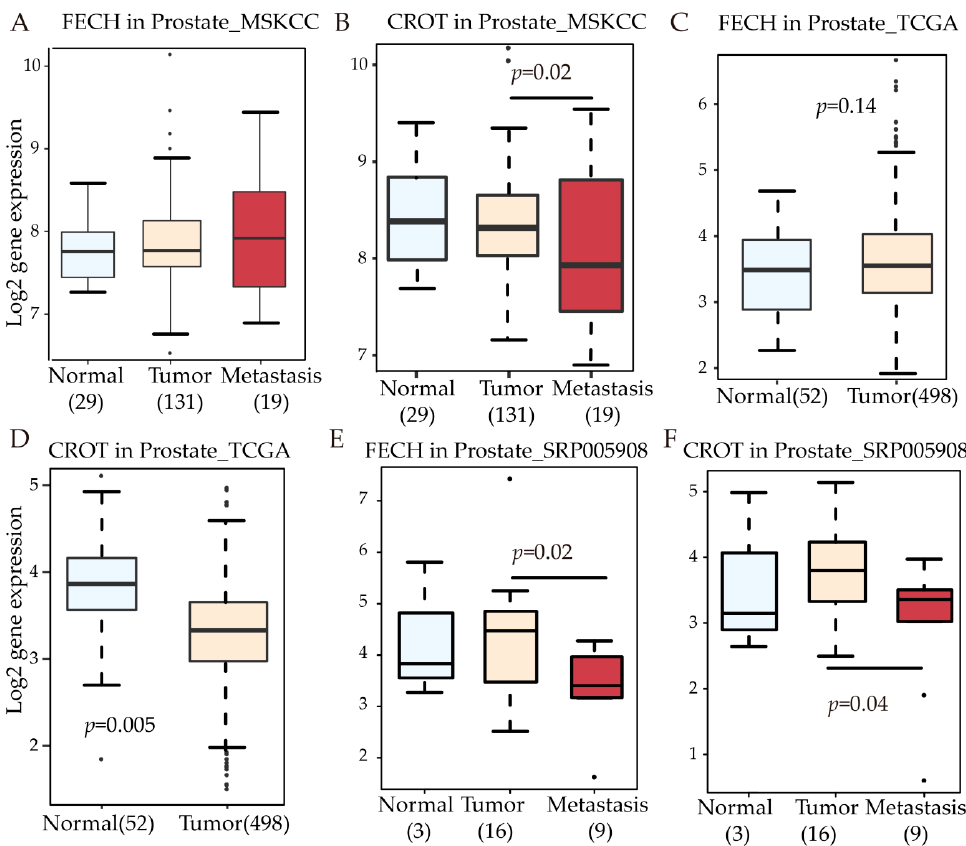
Figure 5. FECH and CROT expression in prostate cancer. ( A ) FECH and ( B ) CROT expression in prostate dataset MSKCC; ( C ) FECH and ( D ) CROT expression in prostate dataset TCGA; ( E ) FECH and ( F ) CROT expression in prostate dataset SRP005908.